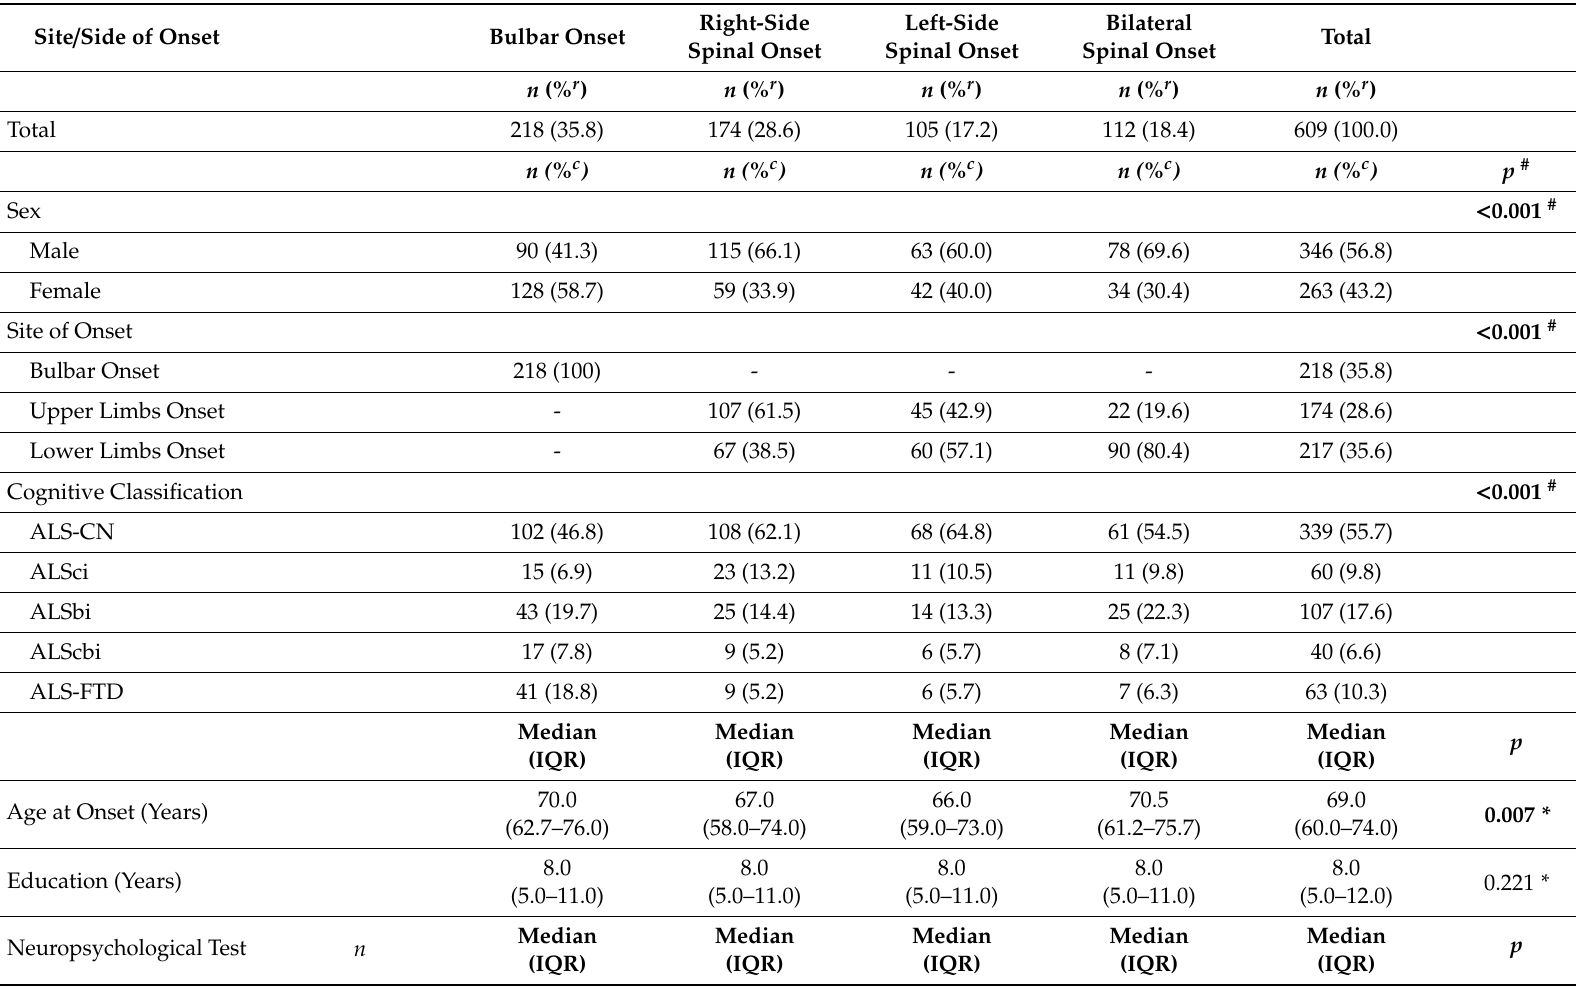
Table 1. Descriptive statistic of amyotrophic lateral sclerosis (ALS) patients subdivided by site of onset (bulbar vs. spinal onset) and side of onset for spinal onset patients (right-side vs. left-side vs. bilateral